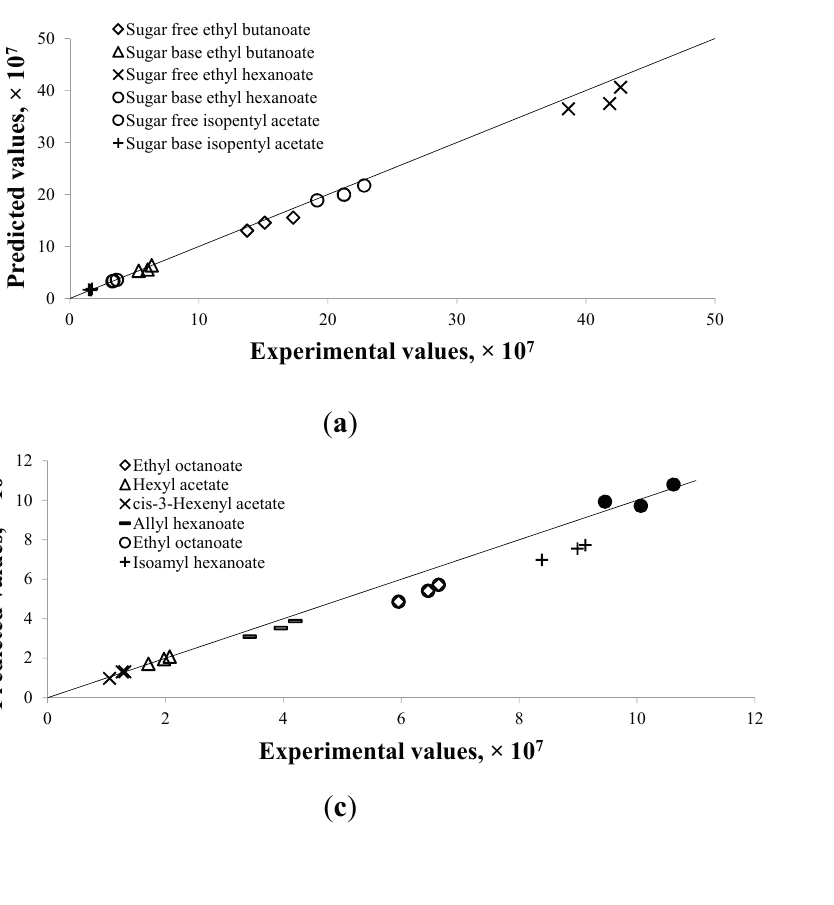
Figure 3. Predicted results versus experimental results for flavor compounds in different food models or processing conditions at designated extraction time. For each compound, the triplicates of Y1, Y2, and Y3 are shown. ( a ) Chewing gum at 60 °C; ( b ) Alcoholic beverage at 30 °C; ( c ) Alcoholic beverage at 40 °C; ( d ) Alcoholic beverage at 60